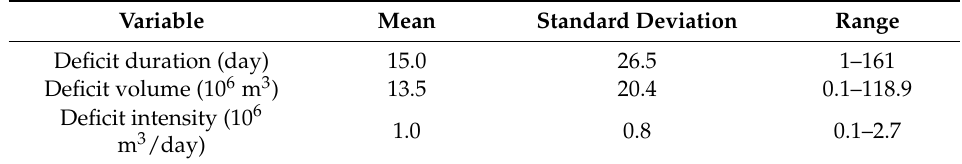
Table 3. The mean, standard deviation, and ranges of three components of the water deficit events observed at the Namgang dam.